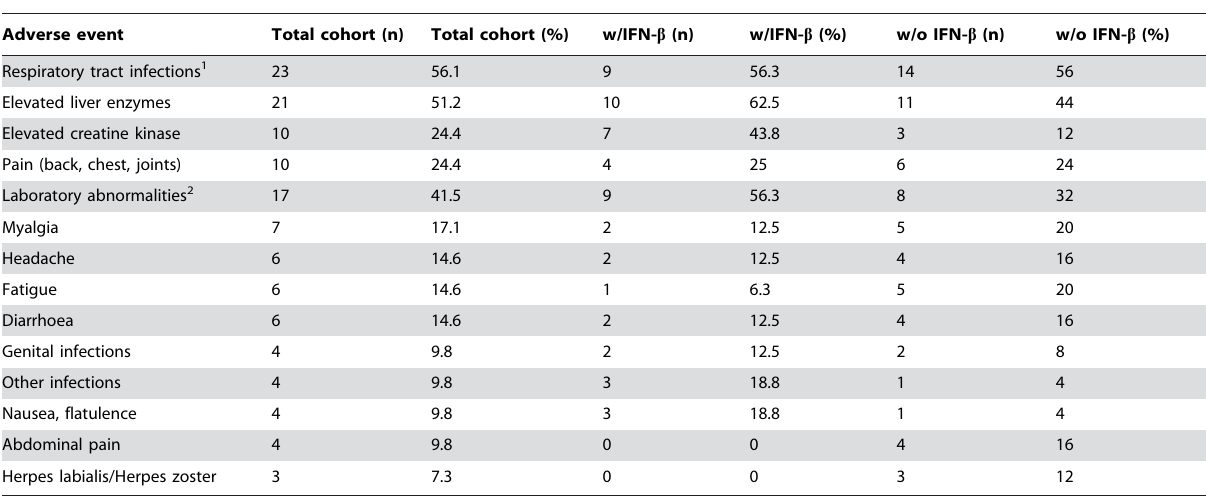
Table 6. Frequency of adverse events as a percentage of study participants (n=41).